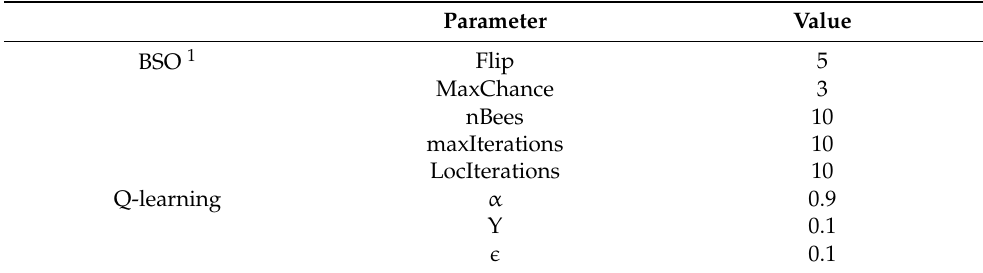
Table 1. The selection of the parameters